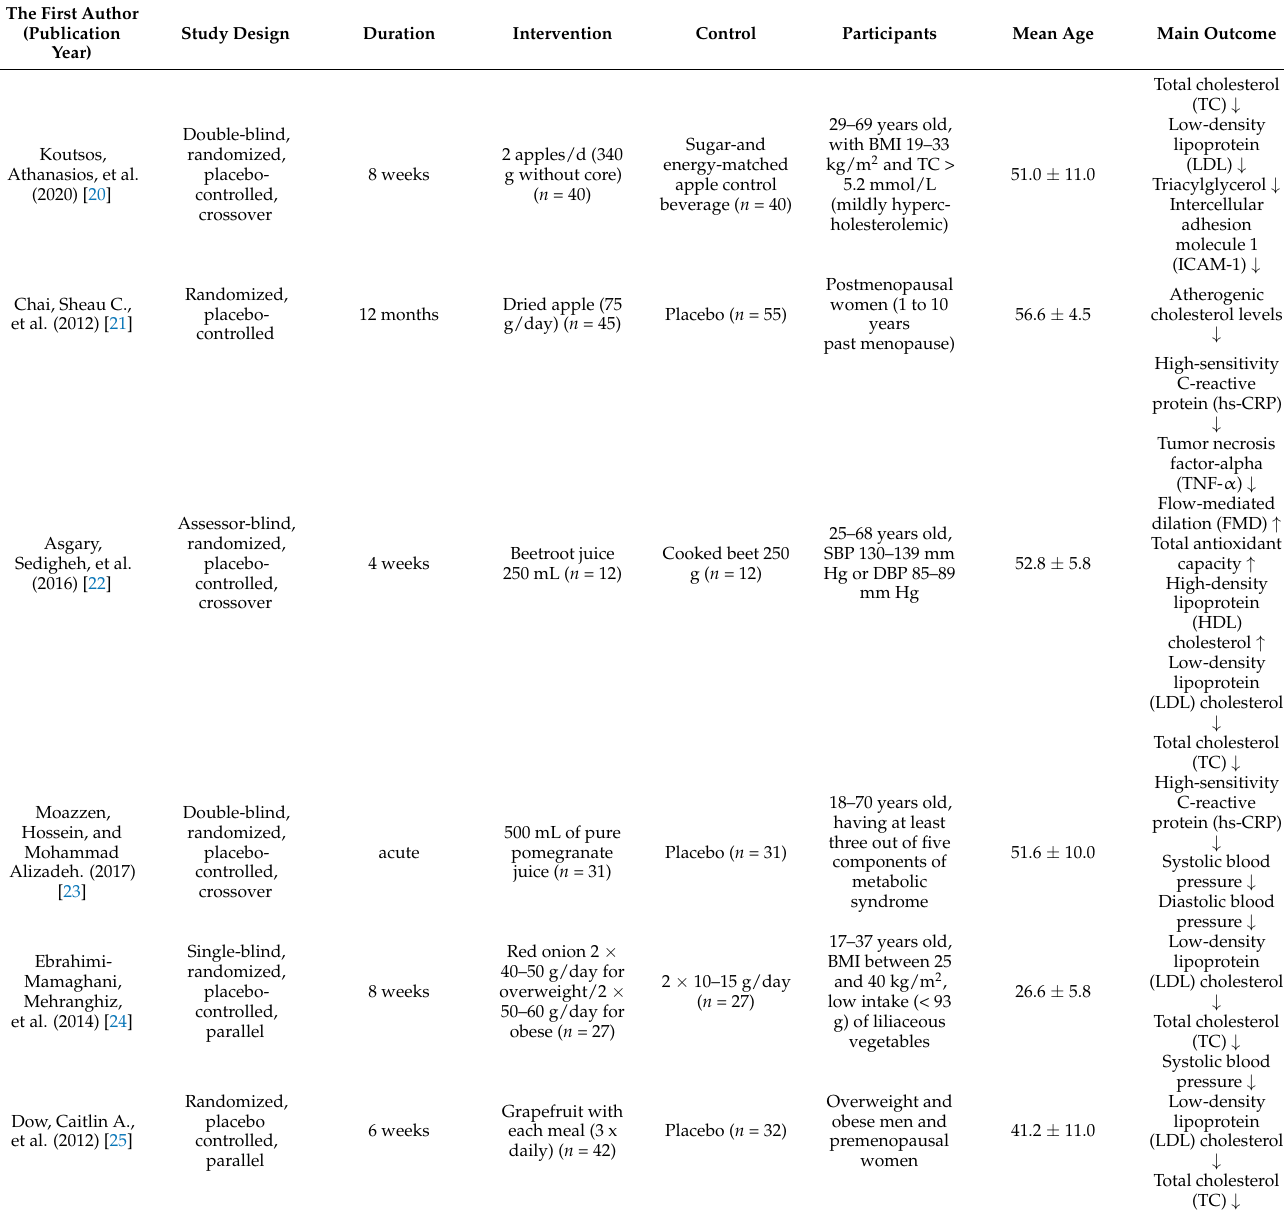
Table 2. Biological activities of red-colored food-derived flavonols, flavones, flavanols, and flavanones.